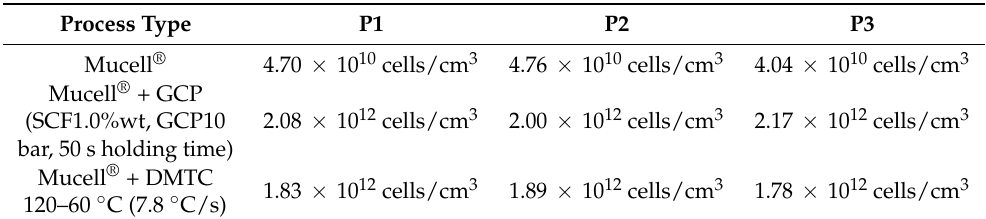
Figure 11. Comparison of foaming morphologies between traditional MuCell ® and its simultaneous combination with GCP and DMTC. ( a ) SEM photograph. ( b ) Cell diameter variations across section at P1. ( c ) Cell diameter distribution at P1. ( d ) Cell diameter variations across section at P2. ( e ) Cell diameter distribution at P2. ( f ) Cell diameter variations across section at P3. ( g ) Cell diameter distribution at P3. Table 11. Averaged cell density comparison between traditional MuCell ® and its simultaneous com- bination with GCP and DMTC.